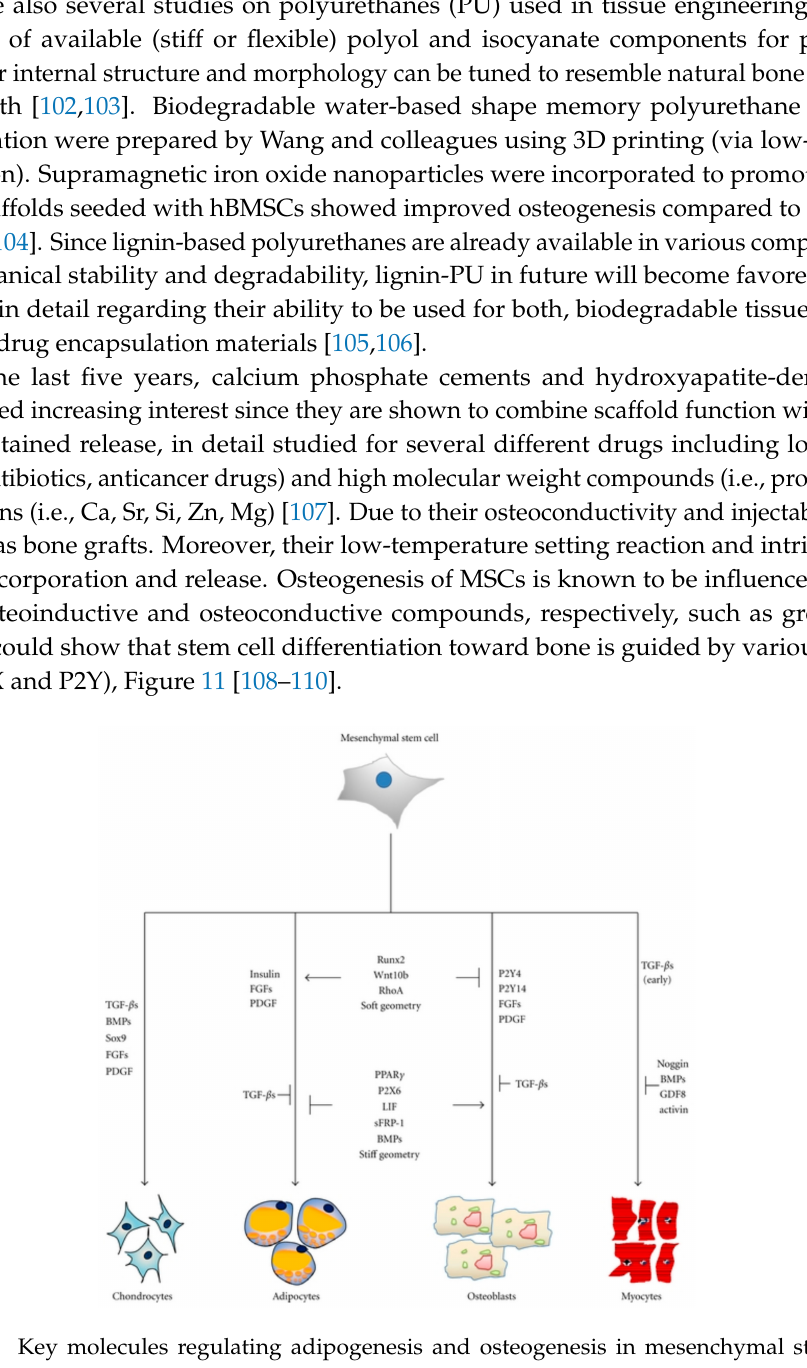
Figure 11. Key molecules regulating adipogenesis and osteogenesis in mesenchymal stem cells. Runx2, Wnt10b, RhoA, and soft geometry can induce osteogenesis while inhibiting adipogenesis